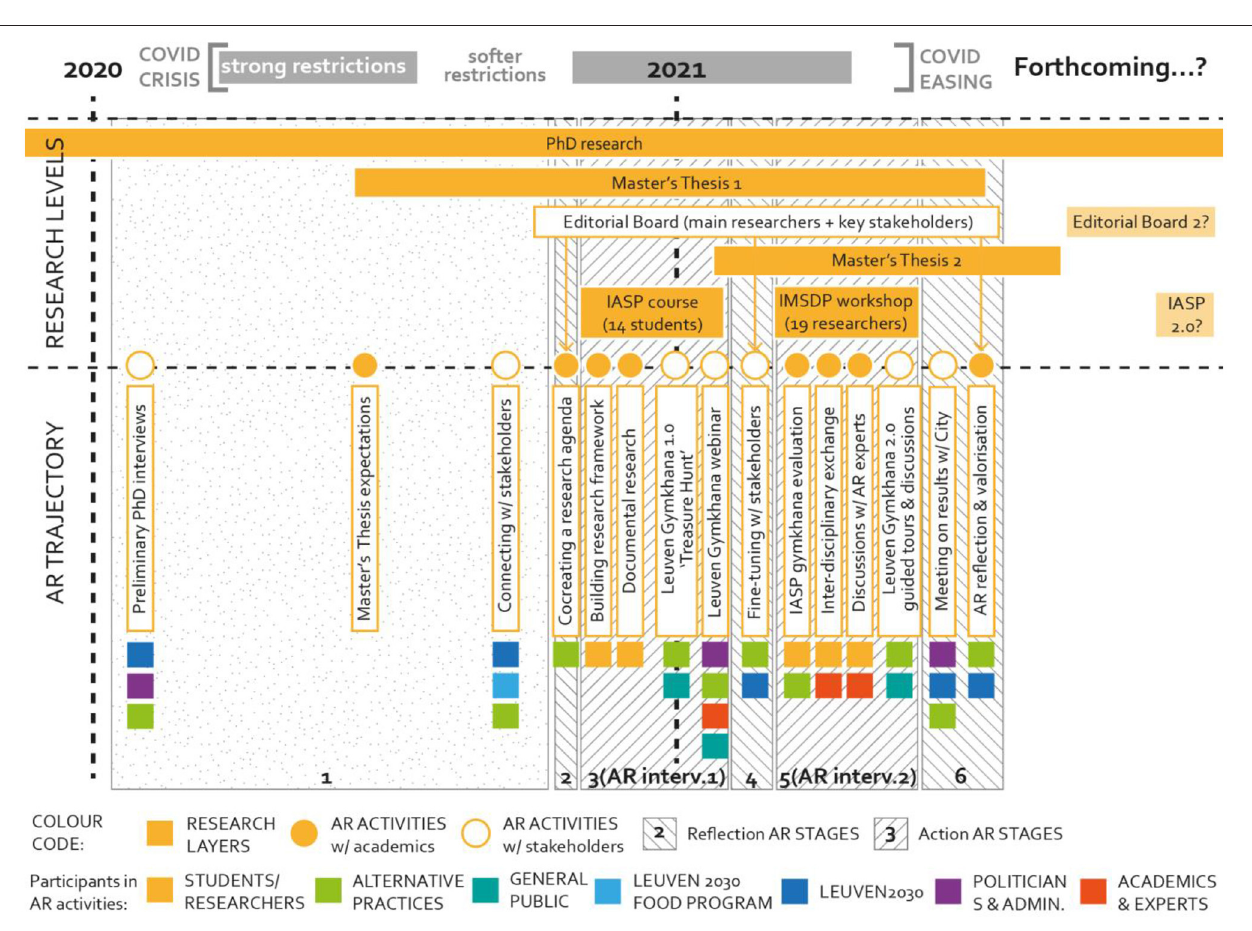
FIGURE 2 | Summary of the action research trajectory, activities, and actors involved. (Source: authors’ adaptation from Medina-García et al., 2022).